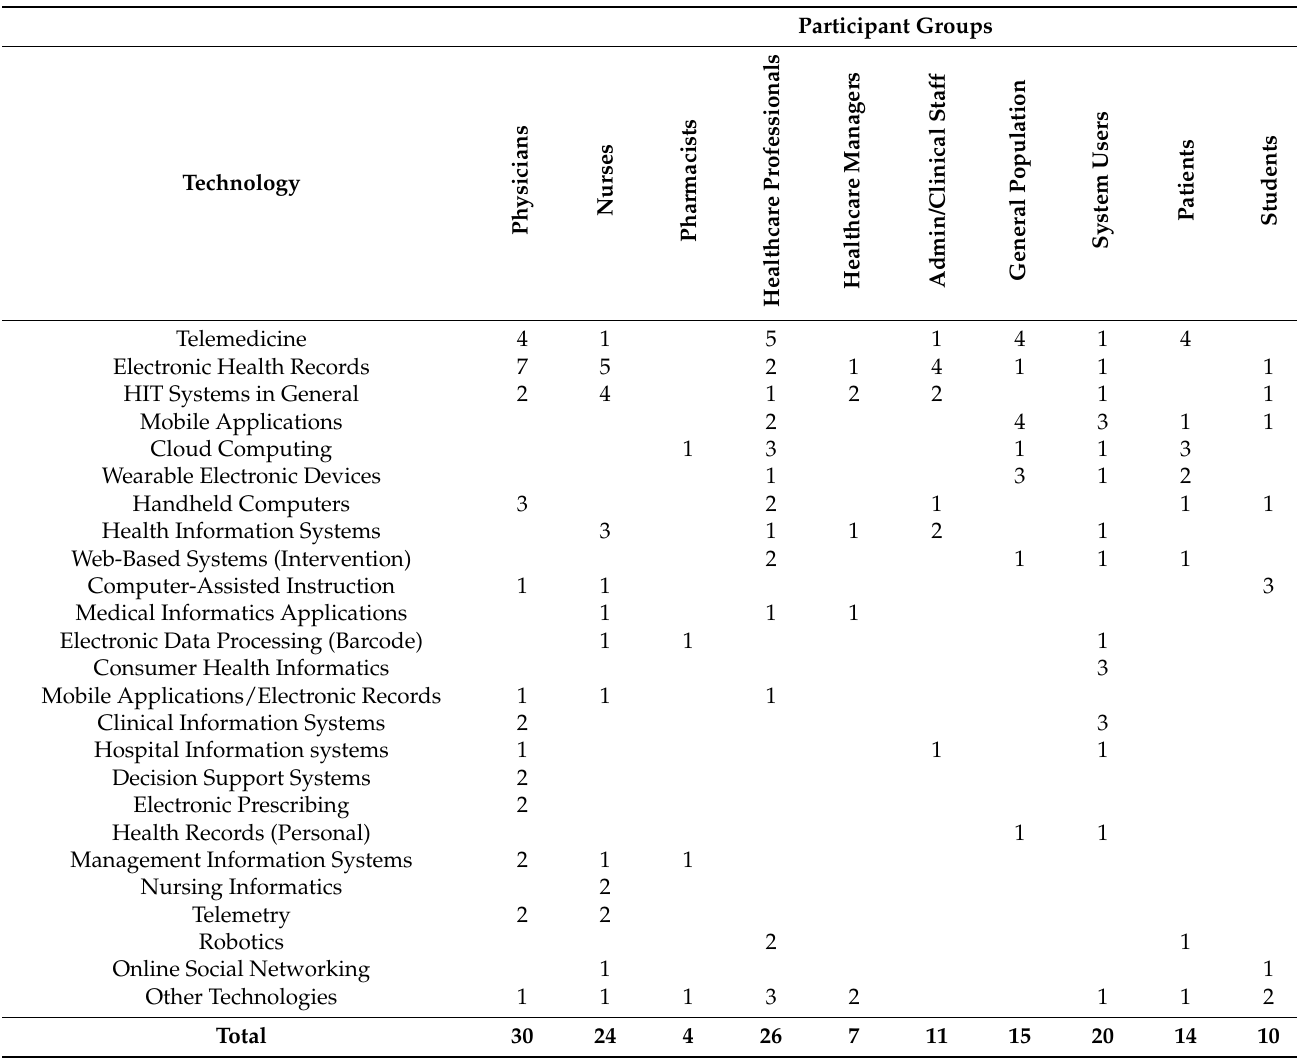
Table 6. Technology types and participants’ groups.